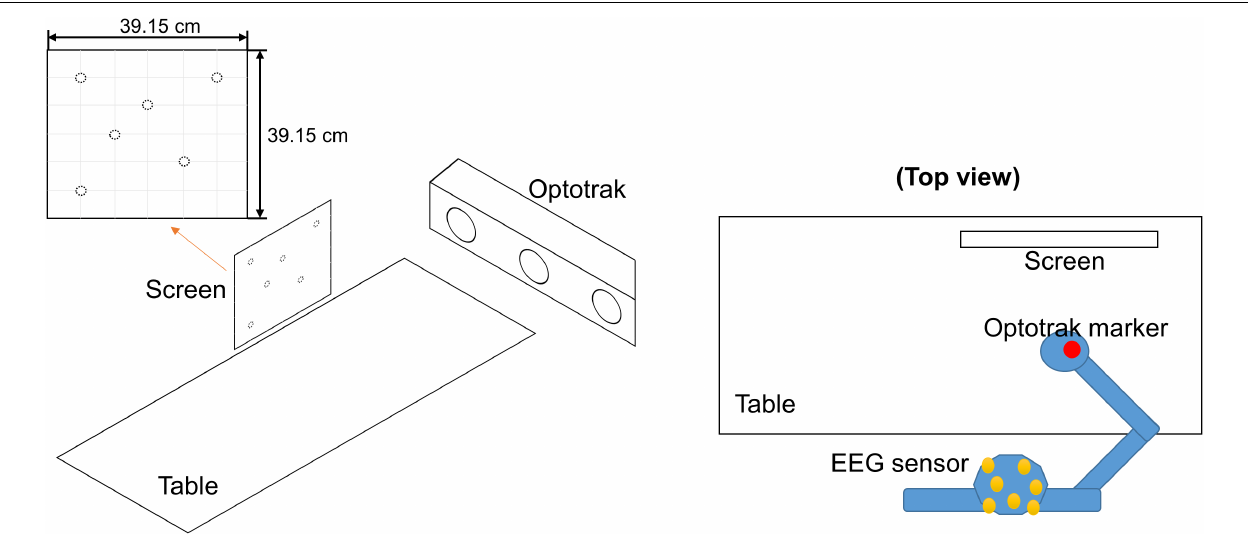
FIGURE 1 | Experimental environment. The participant wore an electroencephalography (EEG) cap and sat at a desk. An Optotrak (motion sensor) marker was attached to the back of his/her right hand, and the marker position was tracked using an Optotrak device from the right side of the hand. The participant moved his/her hand on the table to move the cursor on the screen set in front of him/her. Horizontal movement on the table between right and left directions corresponded to horizontal movement on the screen, while vertical movement across the table between front and back directions corresponded to vertical movement on the screen. The initial cursor position and the target position were pseudo-randomly selected from the six positions that were decided so that all combinations from the six positions should cover all movement parameters (direction, distance, and positions for reaching) used in this research.